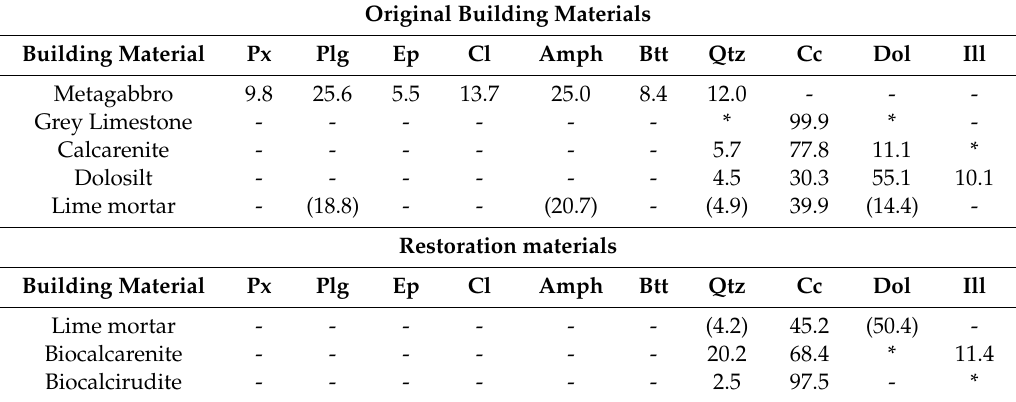
Table 1. Average values of mineral content (%) of the Nueva Tabarca geomaterials analyzed using X-ray di ff raction. Px: pyroxene; Plg: plagioclase; Ep: epidote; Cl: chlorite; Anf: amphibole; Btt: